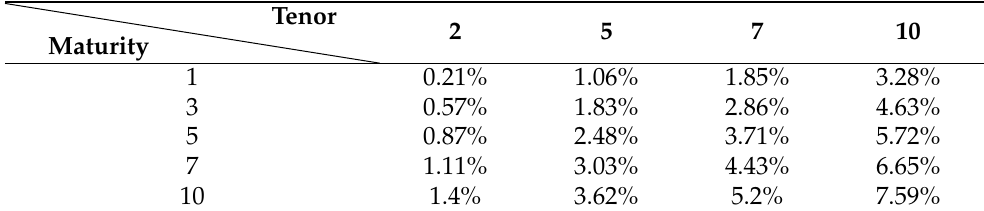
Table A4. Bloomberg’s Hull–White one factor prices of receiver Bermudan swaptions on 30 Decem- ber